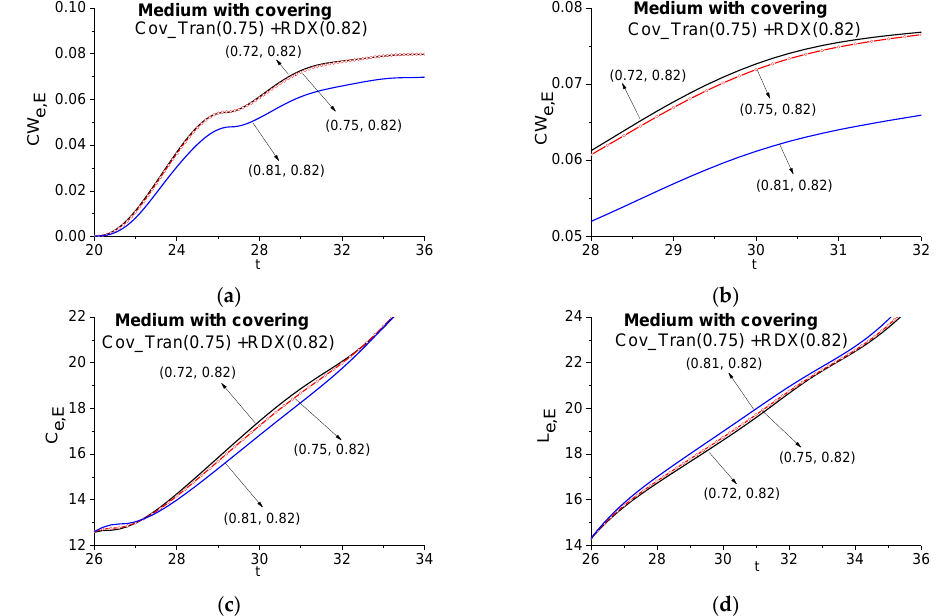
Figure 11. Time-dependent ICC CW e,E ( a ), ( b ), C e,E ( c ), L e,E ( d ) calculated at the frequency ν = 0.75 in the time intervals t = [20, 36] ( a ), [28, 32] ( b ), [26, 36] ( c ), ( d ) for the signal transmitted through the medium with covering (Cov_Tran — a signal under analysis) and the RDX_Air signal as a standard one.